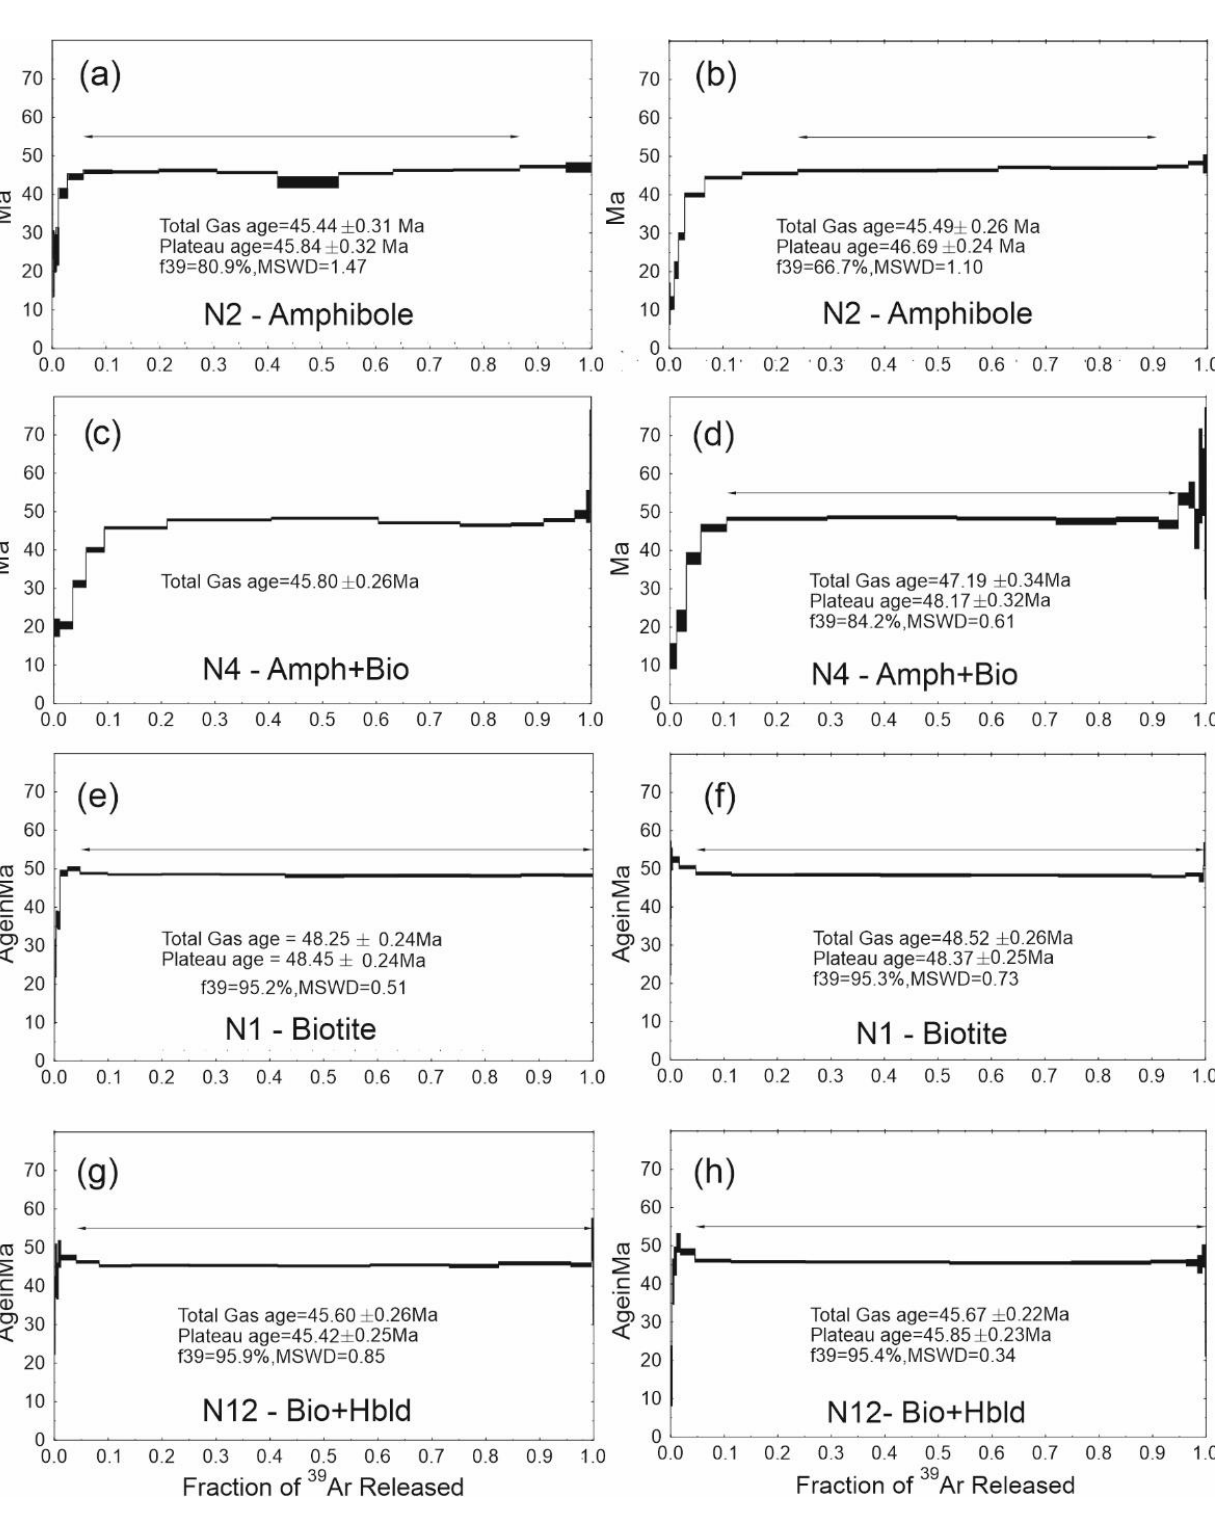
Figure 6. ( a – h ) 40 Ar – 39 Ar age spectra and plateau ages from andesitic and dacitic units of SNV ( a –